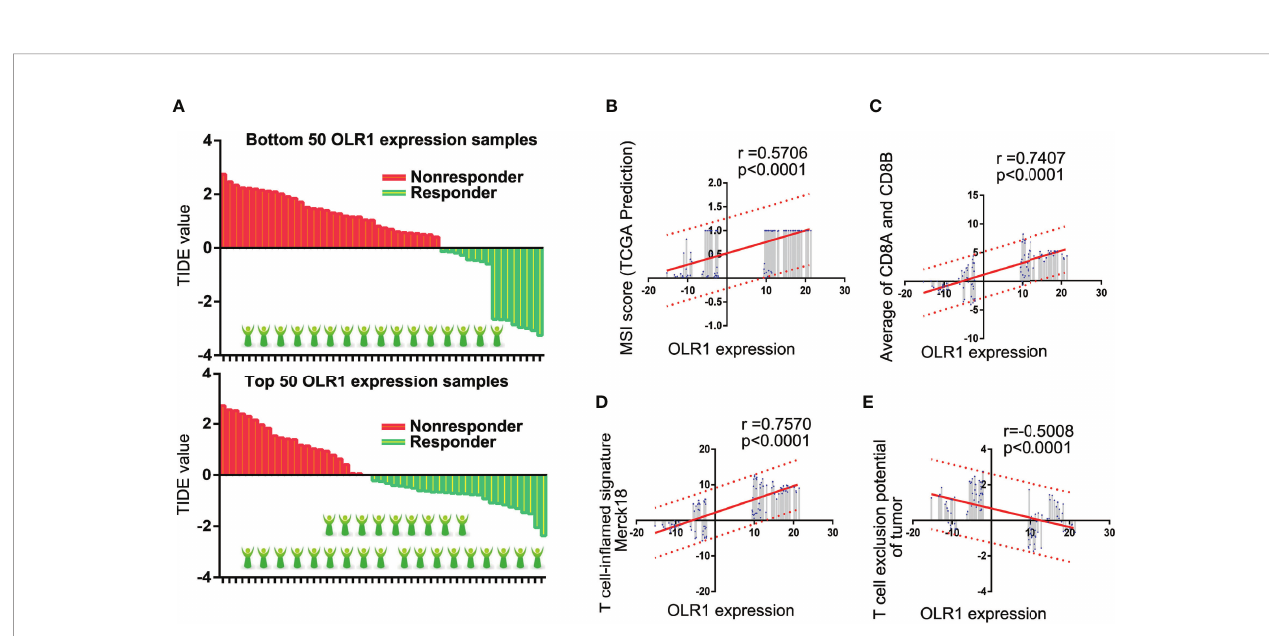
FIGURE 6 | OLR1 may affect the clinical bene fi ts to immunotherapy in NSCLC patients. (A) The comparison of responder number in top or bottom OLR1 expression samples. (B – E) OLR1 has strong positive correlation with some indicators of TIDE